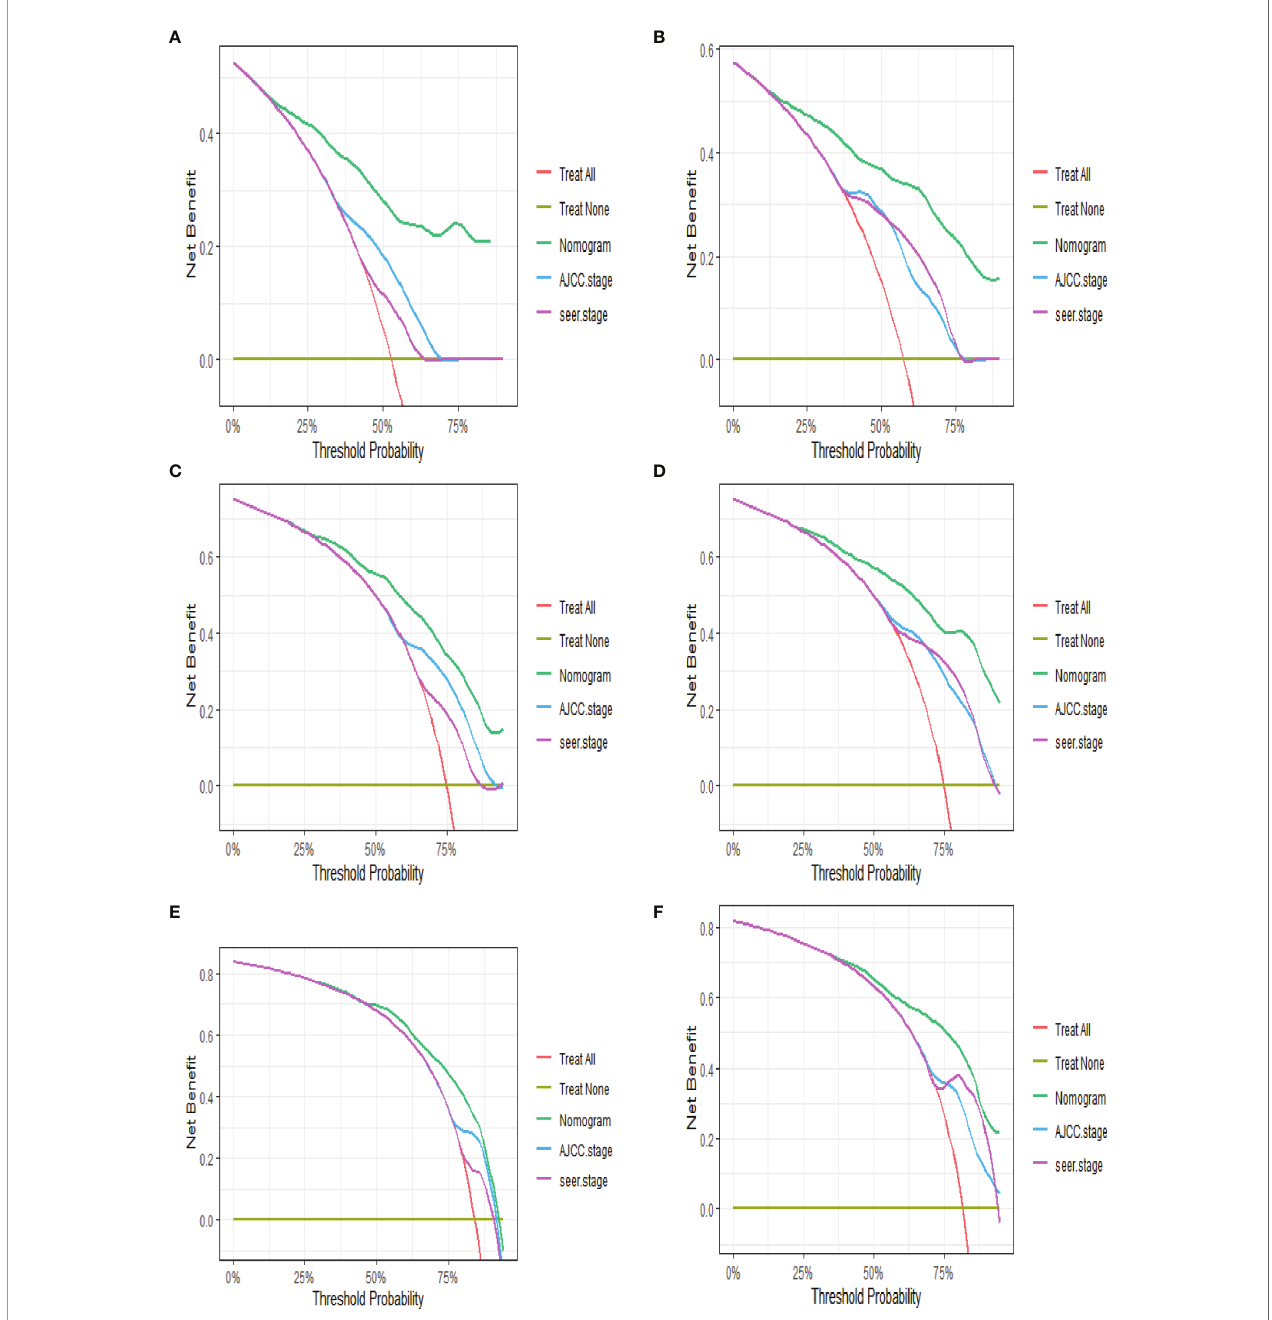
FIGURE 9 | DCA of nomogram (A, C, F) in training group at 6, 12 and 24 months; DCA of nomogram (B, D, E) in validation group at 6, 12 and 24 months (DCA, decision curve